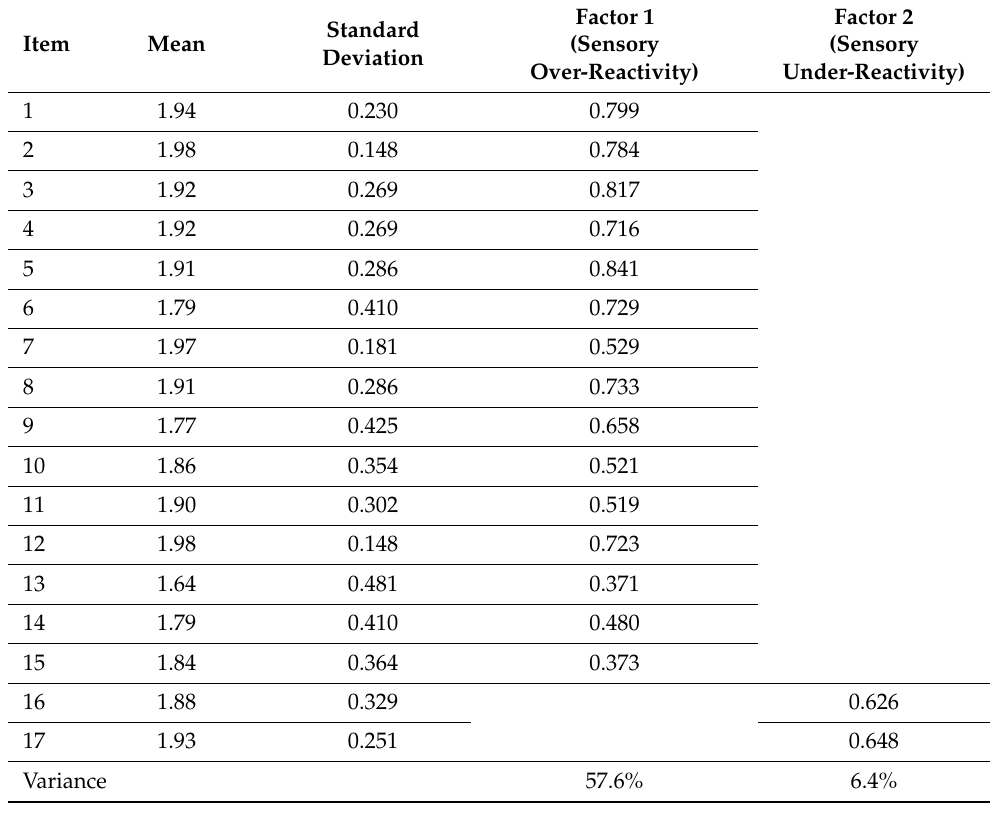
Table 2. Construct validity: exploratory factor analysis (EFA).